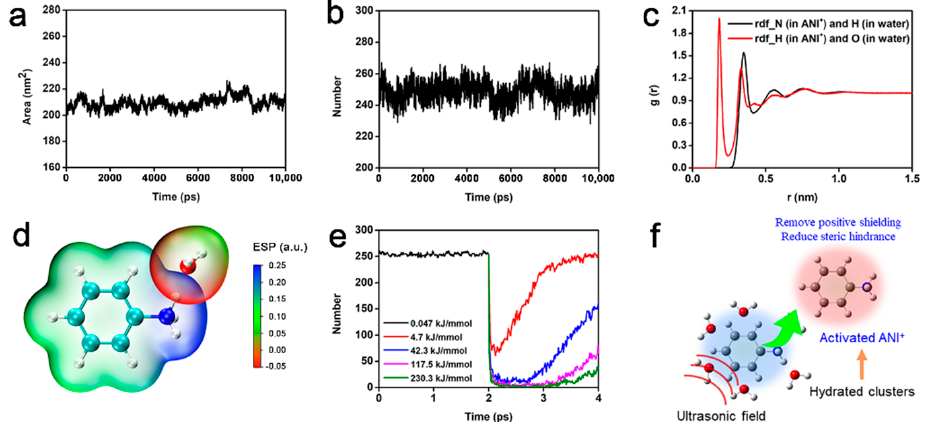
Figure 5. Interactions between ANI + and H 2 O in solution. ( a ) Solvent ‐ accessible surface area of ANI + in solution; ( b ) number of hydrogen bonds formed between ANI + and H 2 O; ( c ) radial distribution function between ANI + and H 2 O; ( d ) RESP mapped van der Waals surface of ANI + and H 2 O; (e) number of hydrogen bonds between ANI + and H 2 O influenced by simulated ultrasonication; ( f ) schematics of the activated ANI + .